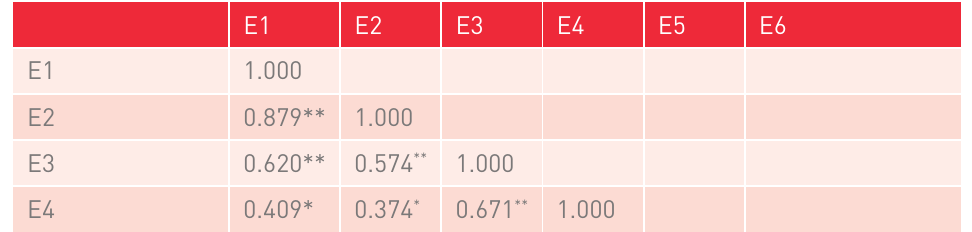
Correlations between the respondents’ career expectations and overall job